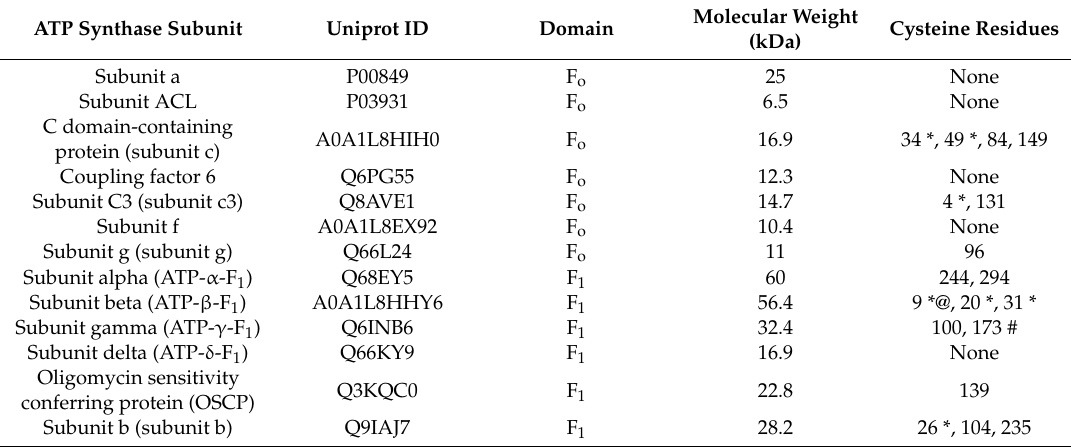
Table 1. Cysteine residues in F 1 -F o ATP synthase in X. laevis . No annotated information could be found for ATP synthase subunit epsilon (ATP- ε -F 1 ), subunit DAPIT, ATP synthase F(0) complex subunit C2, and ATP synthase subunit e (subunit e).